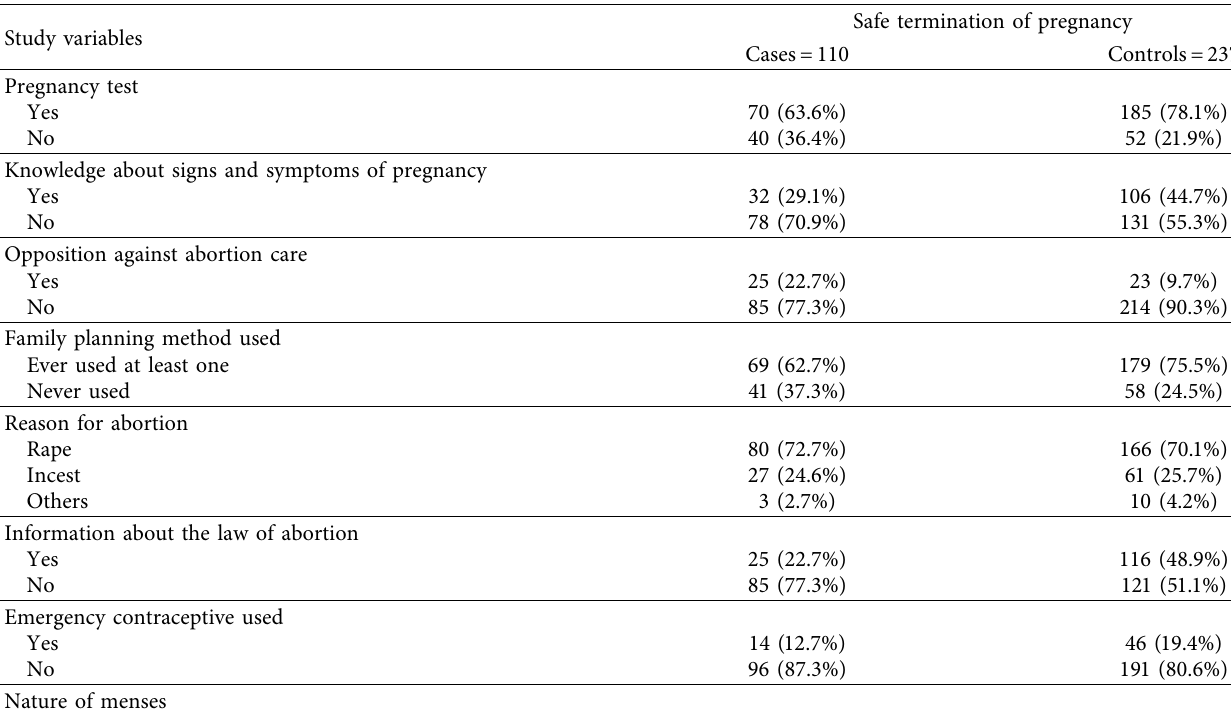
Table 2: Maternal and obstetric characteristics of mothers came to abortion care service, Amhara Region, northwest Ethiopia, 2020 ( N � 347). Study